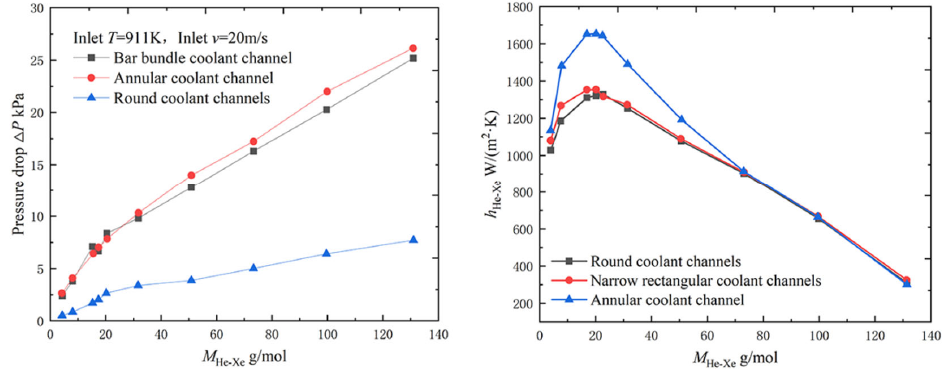
Figure 16. Pressure drop and heat transfer coefficient of the helium–xenon gas mixture in channels of different shapes [9].